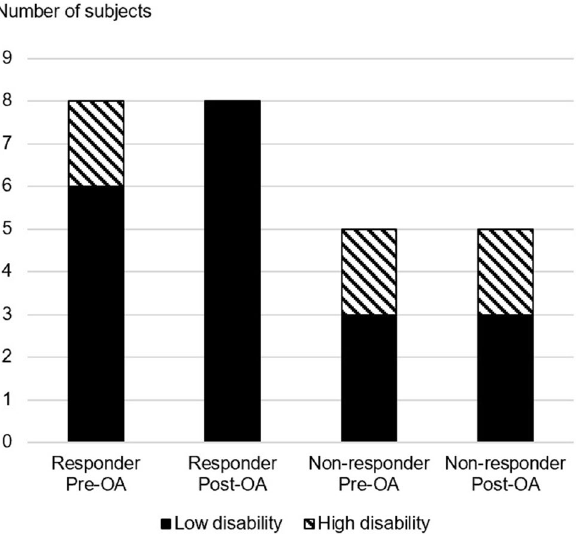
Figure 1. Change in distribution of MIDAS disability groups with oral appliance treatment. Low disability (MIDAS score 0–10), High disability (MIDAS score ≥ 11). OA oral appliance. Microsoft PowerPoint 2019 (Microsoft, Redmond, WA, USA) https ://www.micro soft.com/en-ca/micro soft-365/power point .